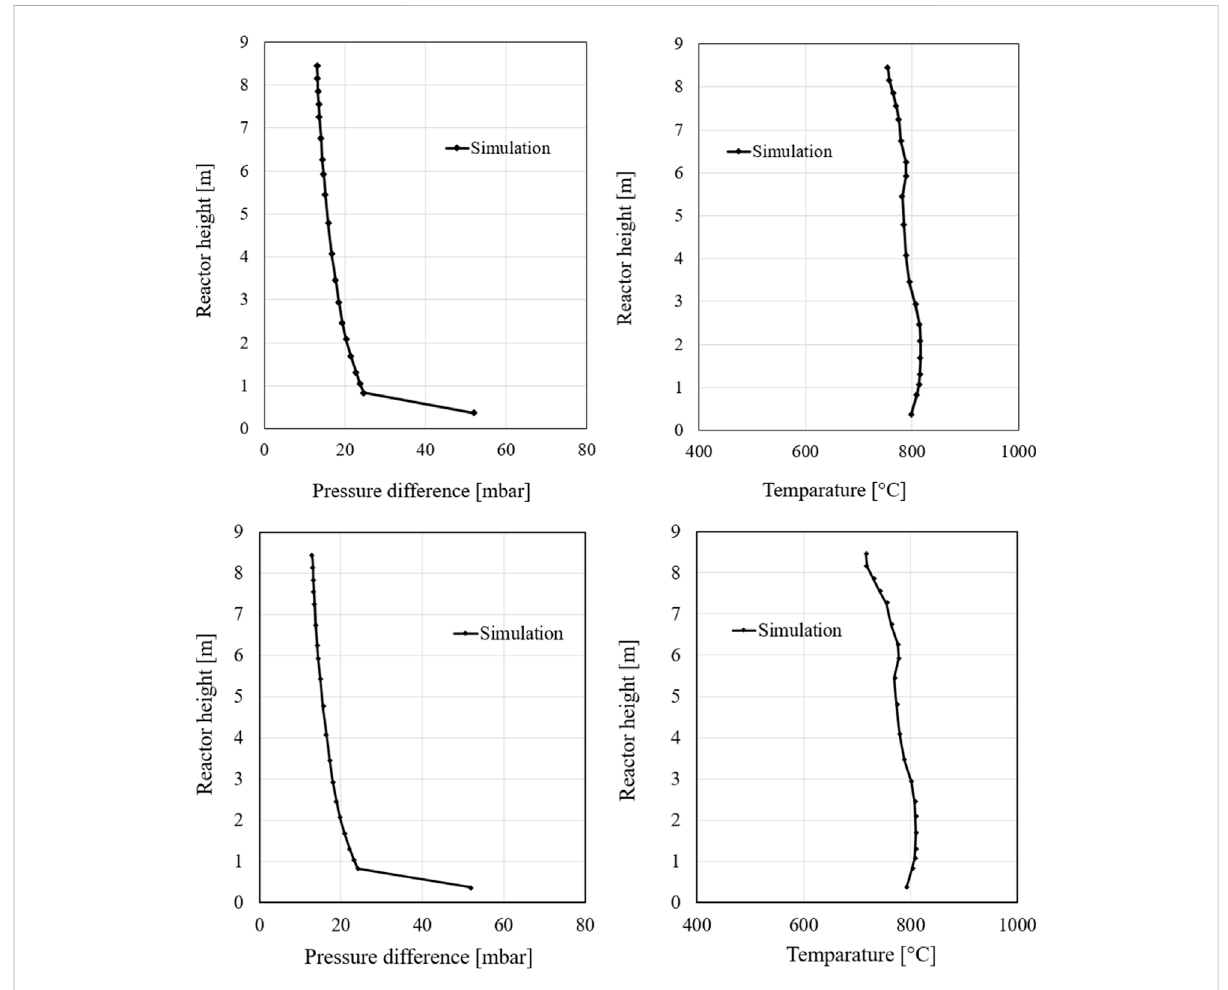
FIGURE 24 Pressure and temperature pro fi le at 40%, 60%, 80% and 100% RDF load